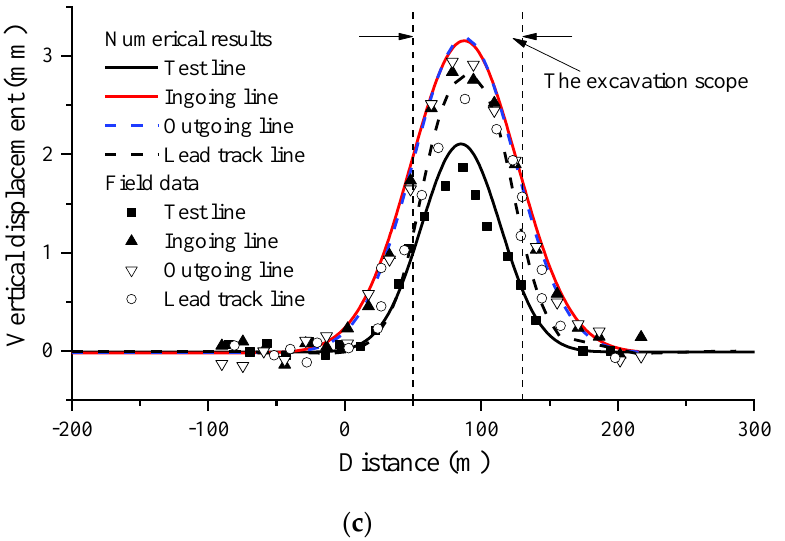
Figure 9. Numerical results and field data of vertical displacement of the tunnel: ( a ) stage 3, ( b ) stage 4, ( c ) stage 5.